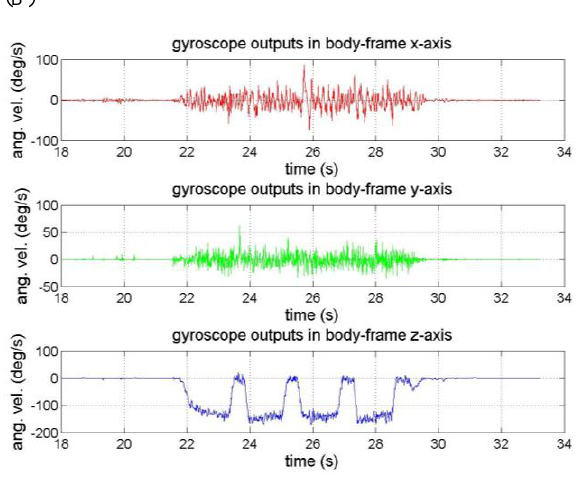
Figure 5. Body frame inertial measurement data, (A) Accelerometer outputs and (B) Gyroscope outputs.